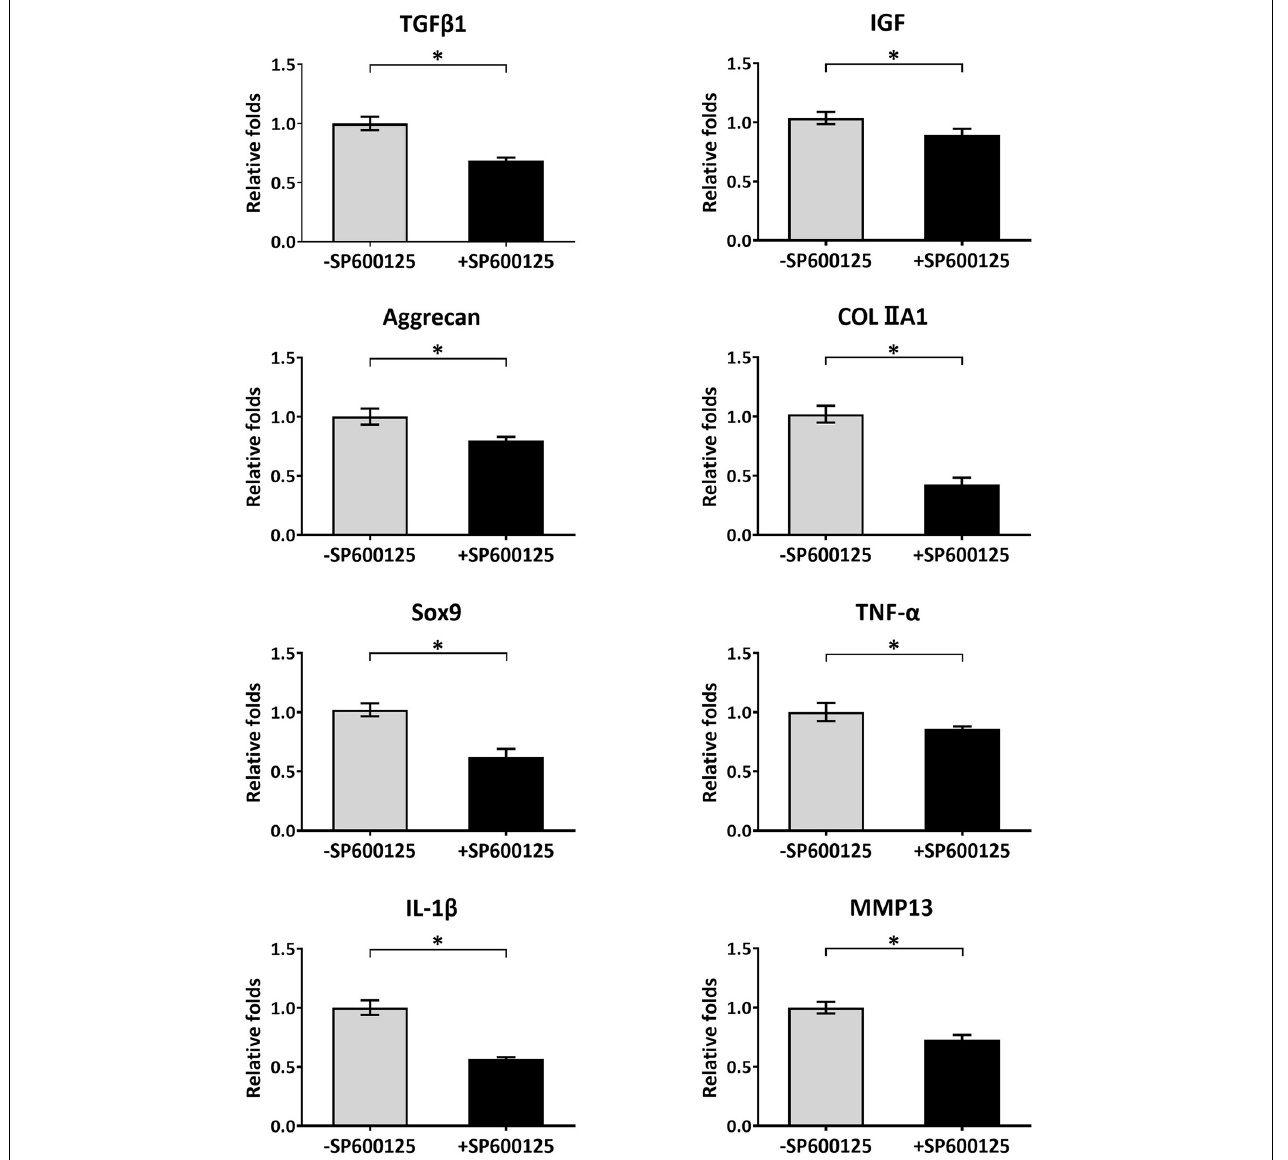
FIGURE 2 | Analysis of cartilage-related and inflammatory-related genes of auricular chondrocytes. After treatment with SP600125 for 24 h, the expressions of cartilage-related genes ( TGF- β 1 , IGF , Aggrecan , COLIIA1 , and Sox9 ) involved in the synthesis of ECM were downregulated. Simultaneously, the expression levels of inflammatory-related genes ( TNF- α and IL-1 β ) and MMP13 , which are involved in ECM catabolism, were significantly downregulated. “*”indicates statistical significance ( p < 0.05). ECM, extracellular matrix; MMP13, matrix metalloproteinase